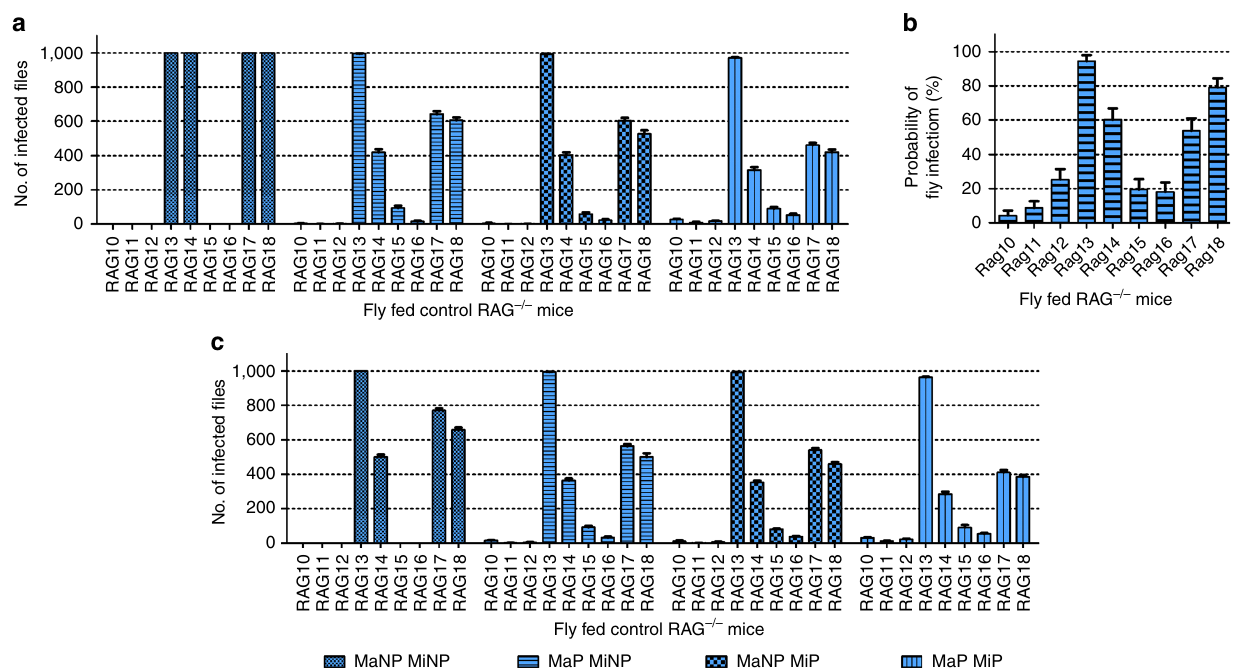
Fig. 5 Predicting outward transmission potential by distribution. a Model predicting host infectiousness to sand fl ies using fi xed parameters (infection threshold = 1000 amastigotes, blood pool volume = 0.19mm 3 , fl y feed volume = 1.6mm 3 ). Either a macro-(Ma)/micro-(Mi) scale homogeneous (MaNP MiNP; NP = non-patchy), a macro-scale patchy micro-scale homogeneous (MaP MiNP; P = patchy), a macro-scale homogeneous micro-scale patchy (MaNP MiP) or a macro-/micro-scale patchy (MaP MiP) distribution is assumed. Graphs are based on 10 model iterations. Standard error bars are shown. b Estimation of probability of sand fl y infection based on experimental sand fl y data. Graphs are based on 10 model iterations. Standard error bars are shown. c Model predicting host infectiousness with infection threshold reduced to 500 amastigotes, a 50% amastigote loss post ingestion and with uniformly random blood pool volumes (0.05 – 0.42mm 3 ) and fl y feed volumes (0.1 – 1.6mm 3 ). Either a macro-(Ma)/micro-(Mi) scale